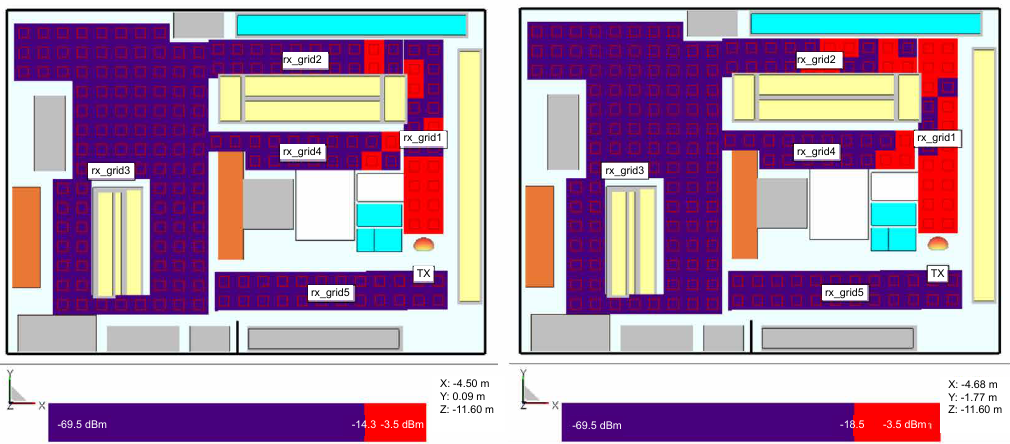
Figure 10. Power distribution for simulation model with mixed products with tags on water product, Higgs 2 ( left ) and Higgs 4 ( right ).